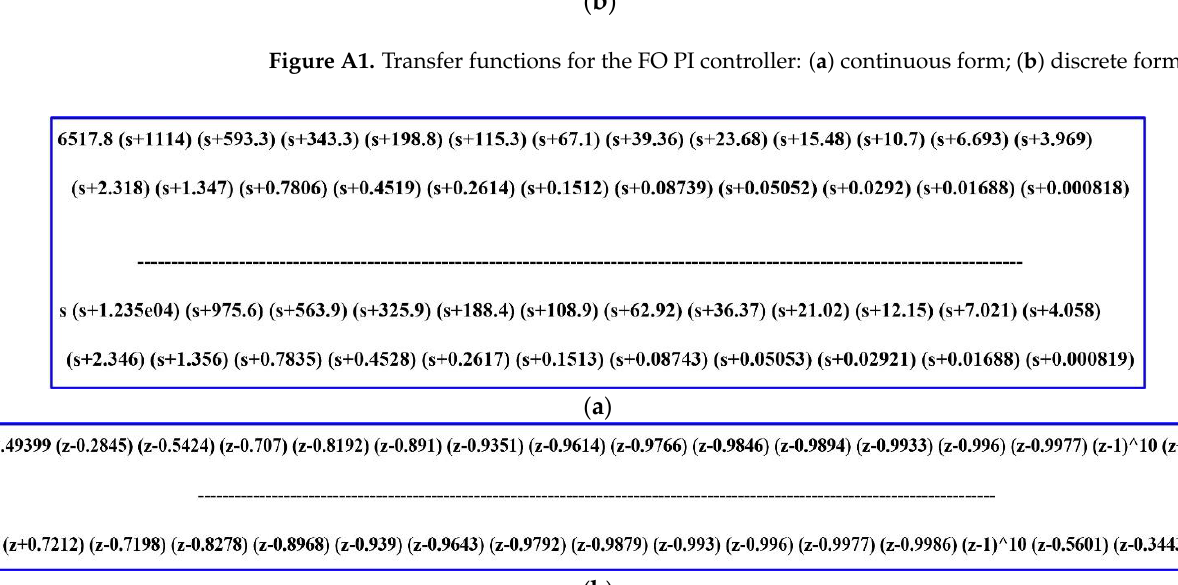
Figure A2. Transfer functions for the FO TID controller: ( a ) continuous form; ( b ) discrete form.